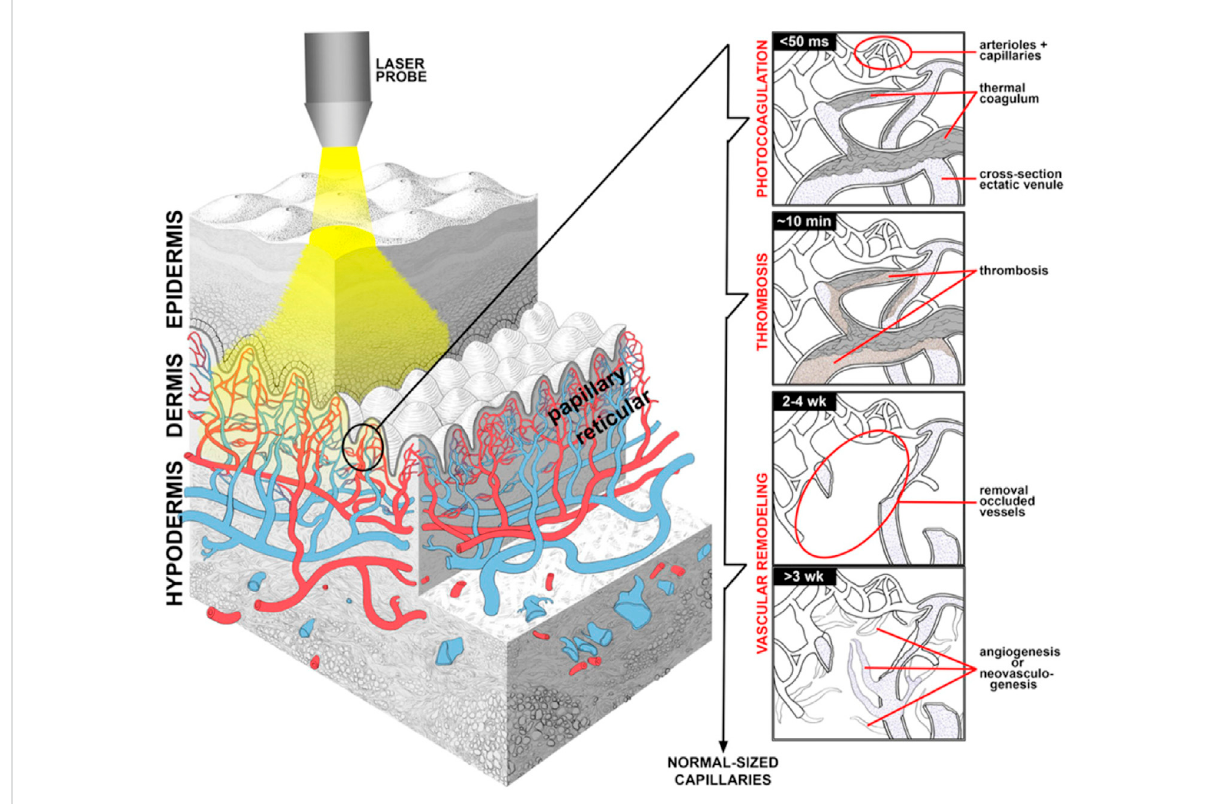
FIGURE 2 PDT treatment for vascular malformations in the fi eld of PRS. (A) Overview of endovascular laser-tissue interactions in pulsed dye laser (PDL) treatment of refractory port wine stain (PWS) skin. Yellow light-emitting PDL is used to selectively photothermolyze ectatic venules (blue structures) in predominantly papillary dermis from Chen et al.